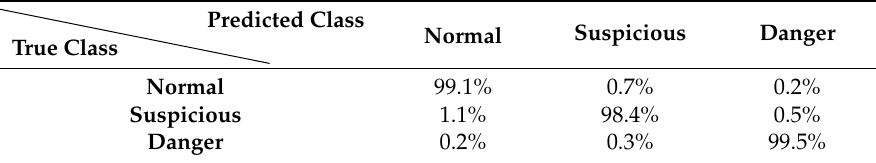
Table 6. Confusion matrix for the optimized decision